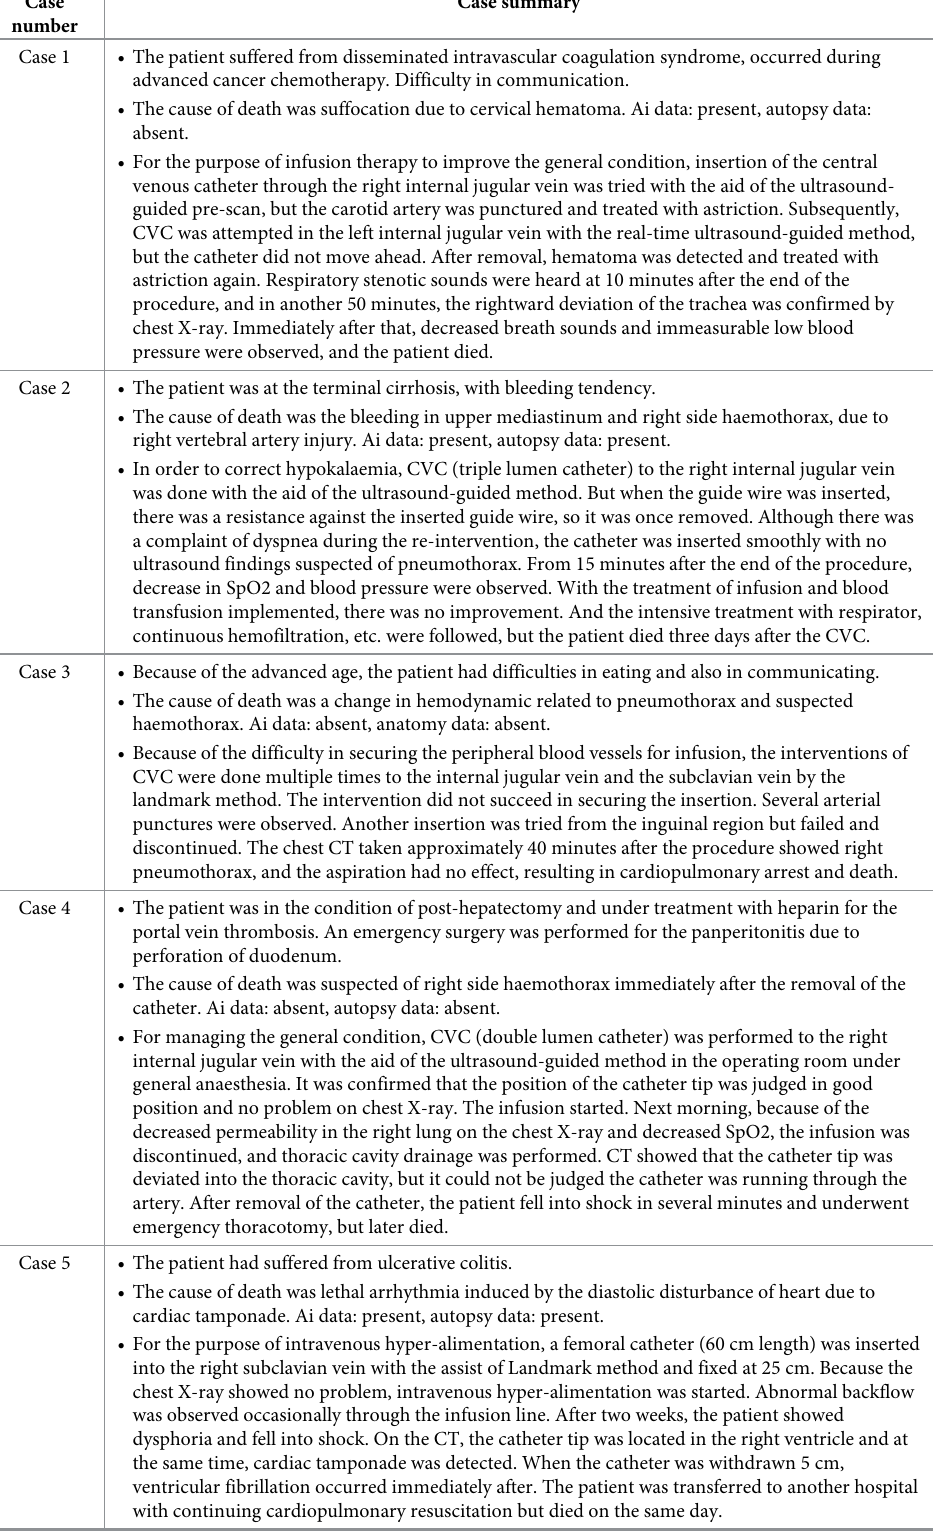
Table 2. Summaries of reported cases from